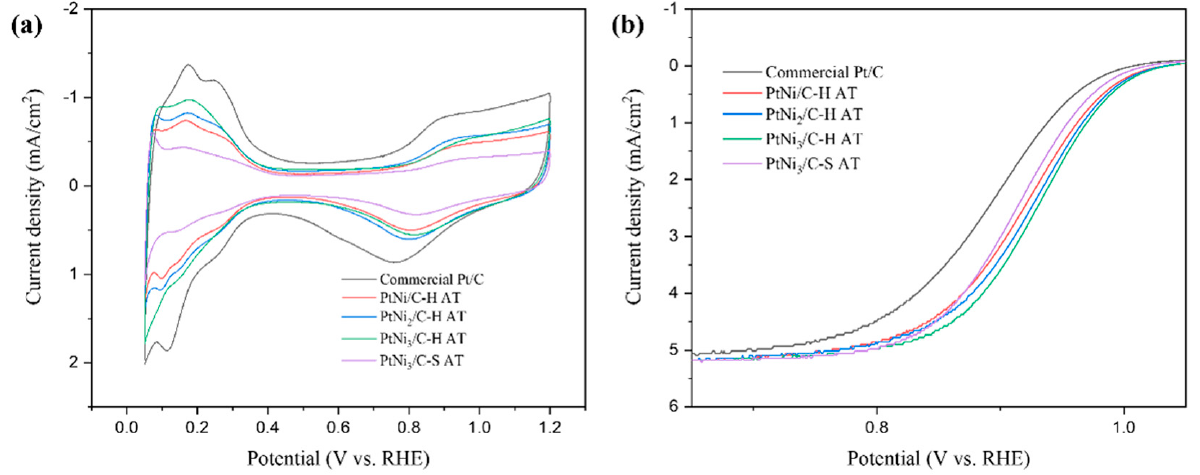
Figure 7. ( a ) CV and ( b ) ORR LSV of the catalysts after acid treatment.